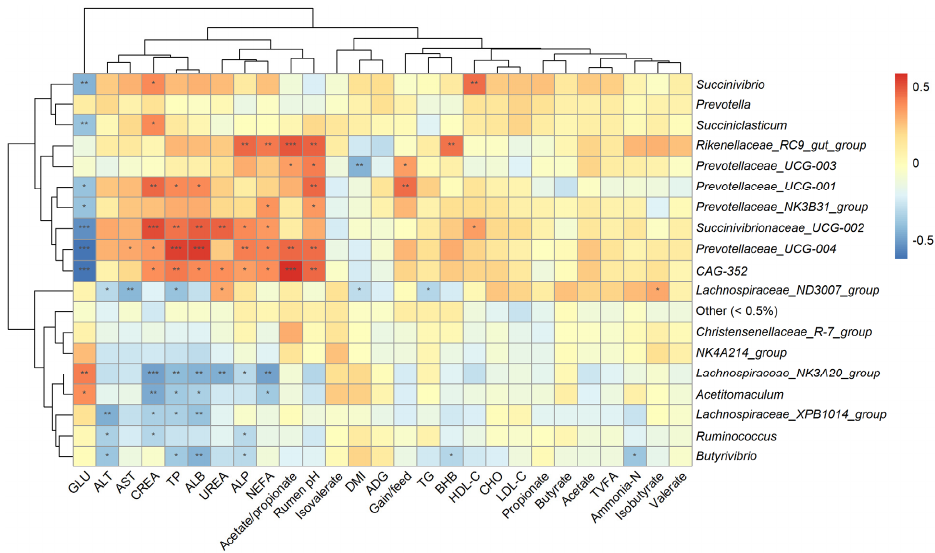
Figure 2. Heatmap of the correlations of genus abundance with fattening performance, serum biochemical parameters, and rumen fermentation. The top and left hierarchical cluster was performed based on the corresponding correlation matrix using the complete linkage method. Lattices are colored based on the corresponding Spearman’s rank correlations. *, **, and *** represent P values smaller than 0.05, 0.01, and 0.001, respectively.